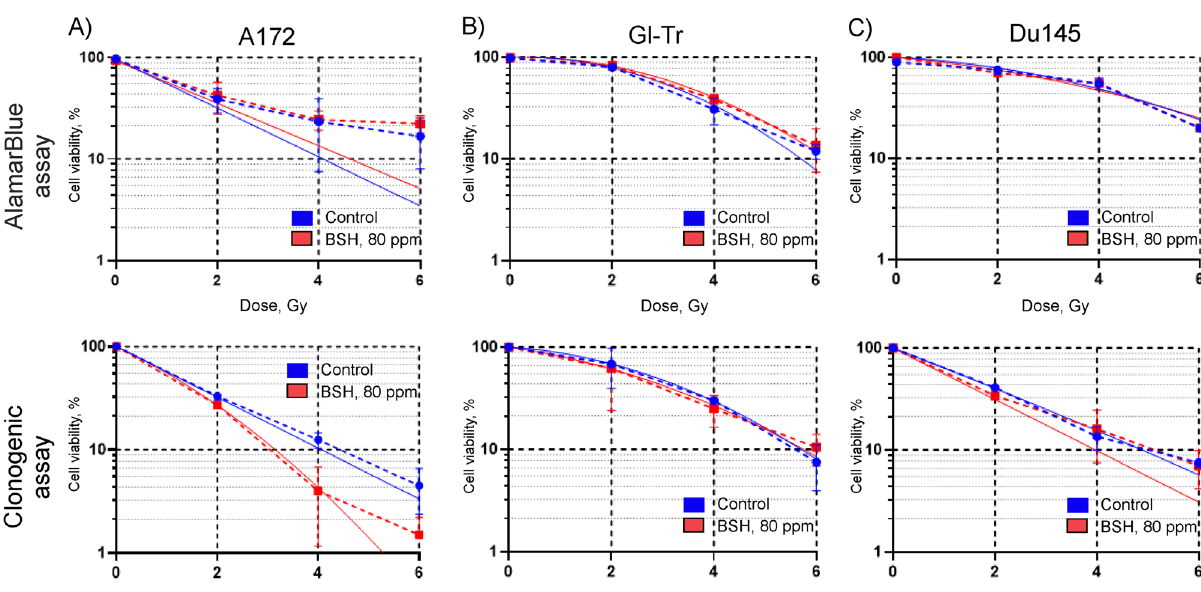
Figure 5. Comparison of cell survival under combined exposure to 80 ppm boron-11 and irradiation at the middle position of Spread-Out Bragg Peak of 200 MeV proton beam. Summary plots for AlamarBlue (up panels) and colony forming assays (bottom panels): ( A ) A172 cells, ( B ) Gl-Tr cells, ( C ) Du145 cells. The cells were incubated in a medium containing 80 ppm of boron-11 for 18 h and then irradiated by 200 MeV proton beam in a dose range of 0–6 Gy. Data were fitted with a linear-quadratic function of the radiation dose (solid lines) with the parameter β constrained to non-negative